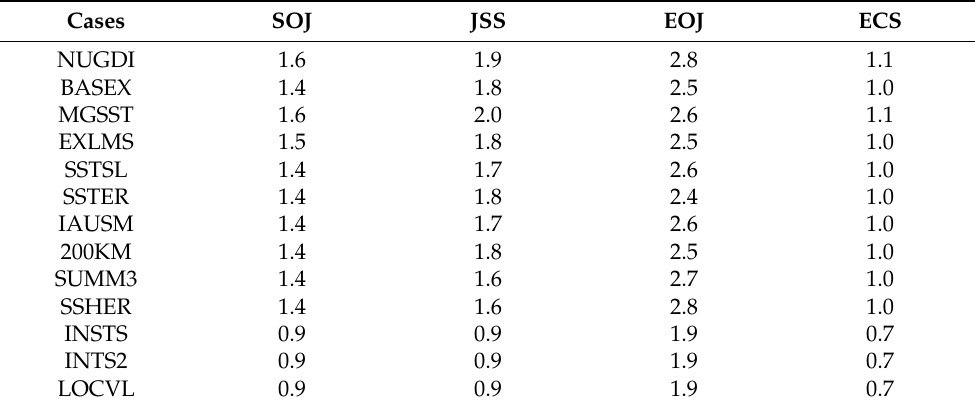
Table 3. Regionally calculated RMSD (in ◦ C) between modeled and observed GTSPP temperature data at 0–100 m depths for the period from 1 July to 31 August 2020. Locations of the observed temperature data are shown in Figure 11a.